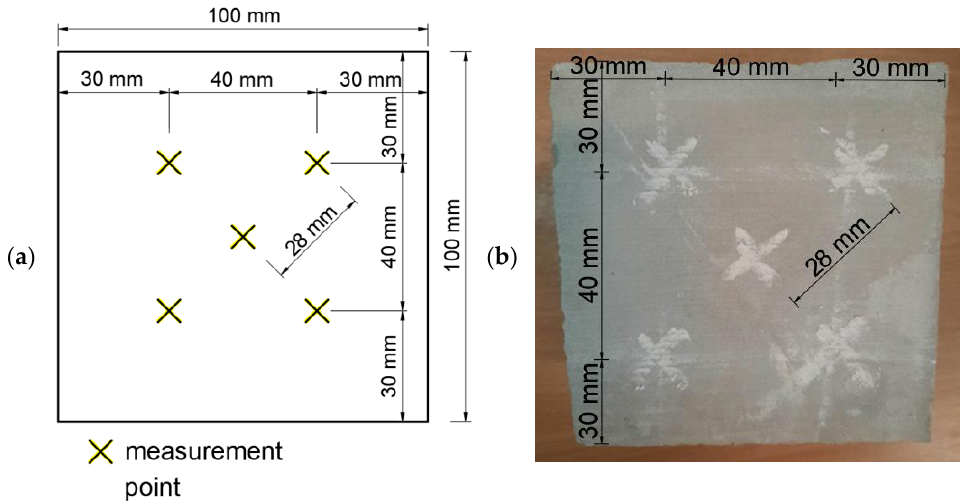
Figure 2. View of the samples with marked measuring points: ( a ) distances shown in the diagram and ( b ) distances marked on a sample.